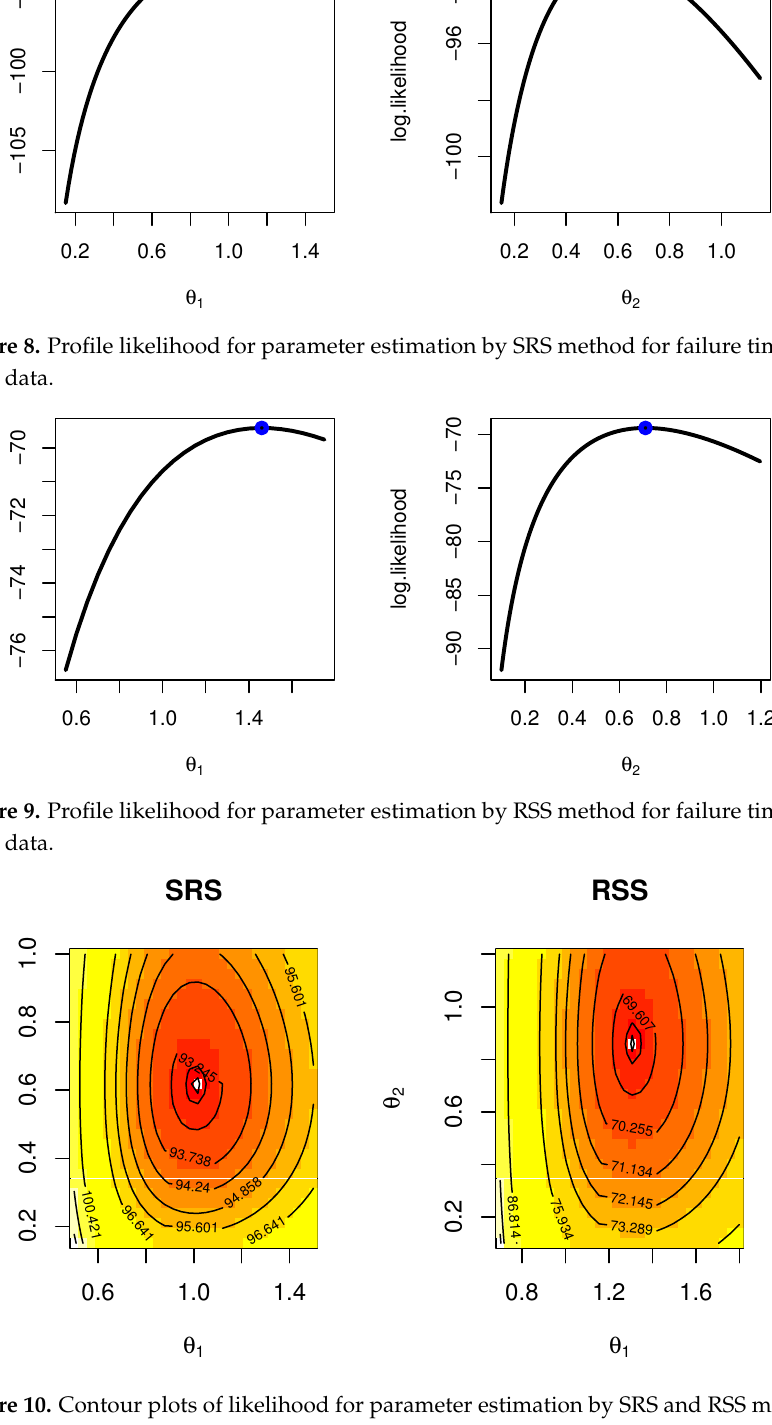
Figure 10. Contour plots of likelihood for parameter estimation by SRS and RSS method for failure times of insulating fluid